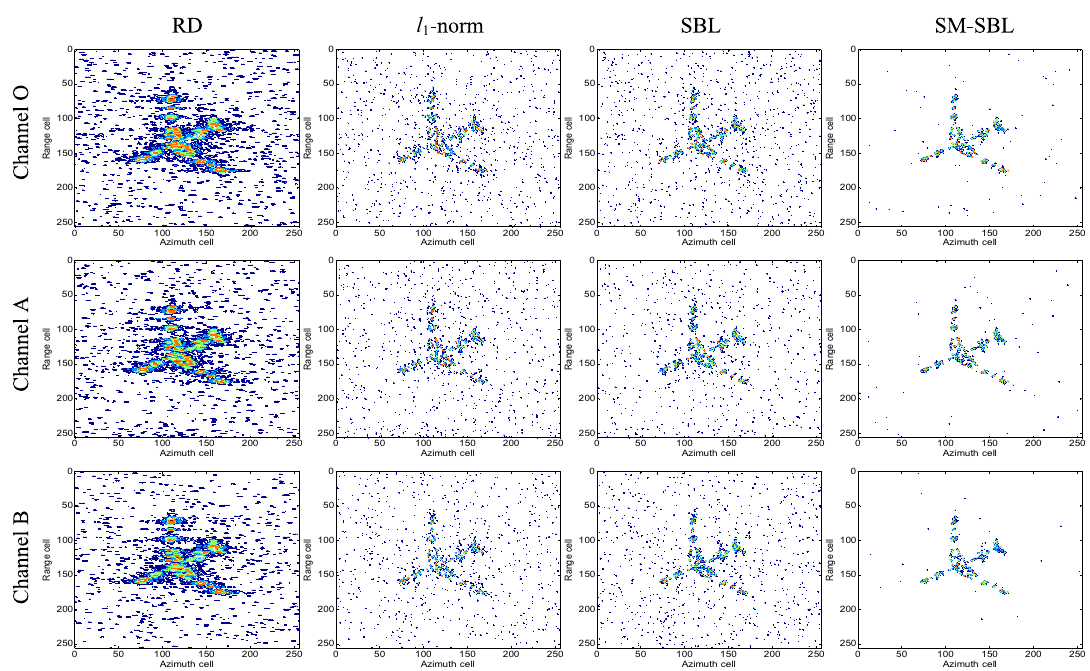
Figure 6. Inverse synthetic aperture radar (ISAR) imagery results for gap missing sampling